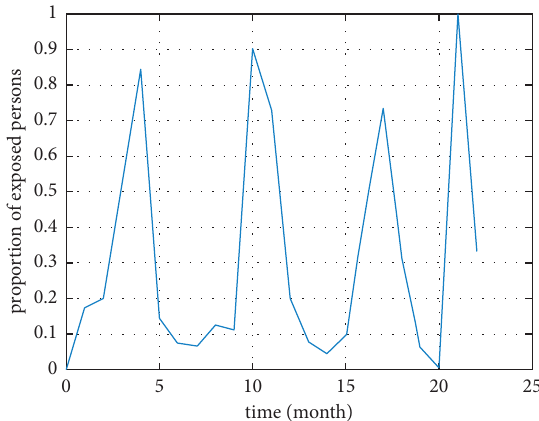
Figure 8: Proportion of the exposed people from March 2020 to January 2022.